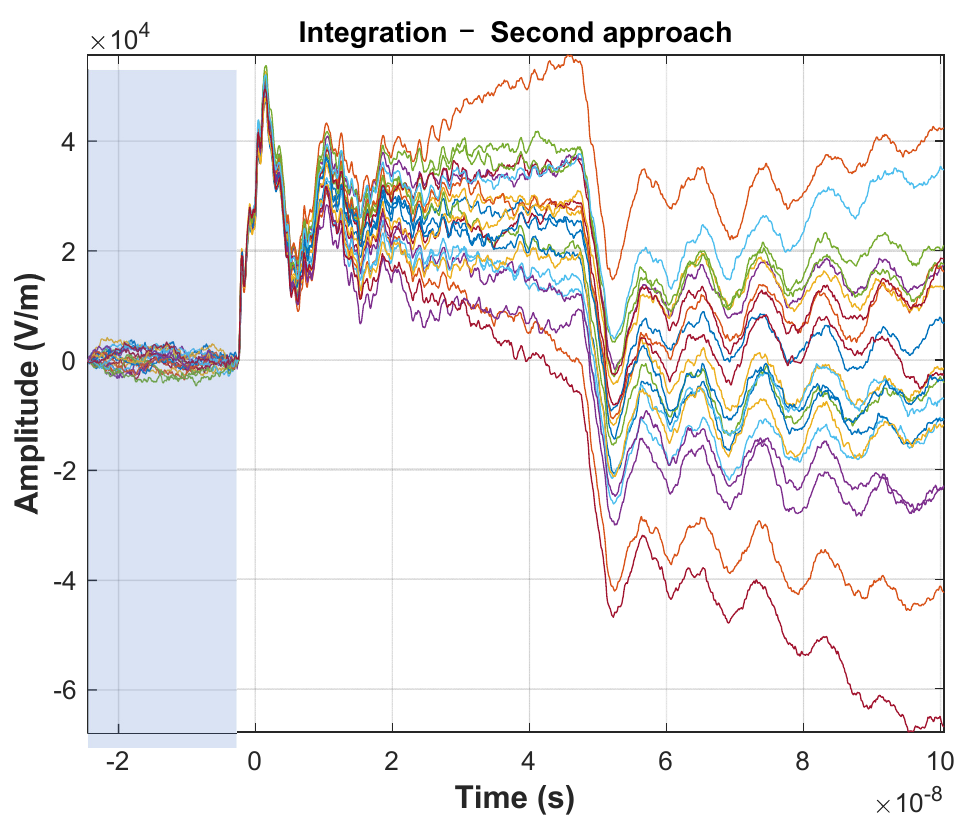
Figure 7. Integrated signal with mean value computed only for the pre-trigger region (blue region) and subtracted from all acquisition window signals.